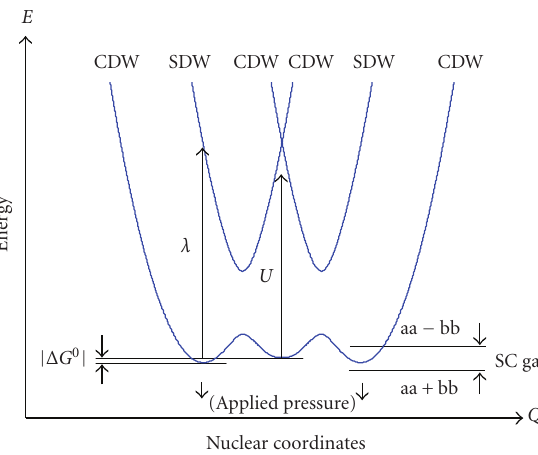
Figure 2: PESs of the MV-3 model. Curvatures are exaggerated. λ is reorganization energy. The fat horizontal bars are vibronic energy levels. aa + bb and aa − bb denote approximate wave functions for the given energy levels. For NH 3 K 3 C 60 , NH 3 Rb 3 C 60 , and Cs 3 C 60 , the SDW-PES is lower than CDW-PES. Fat arrows show the behavior of CDW-PES at applied pressure. | Δ G 0 | is defined by